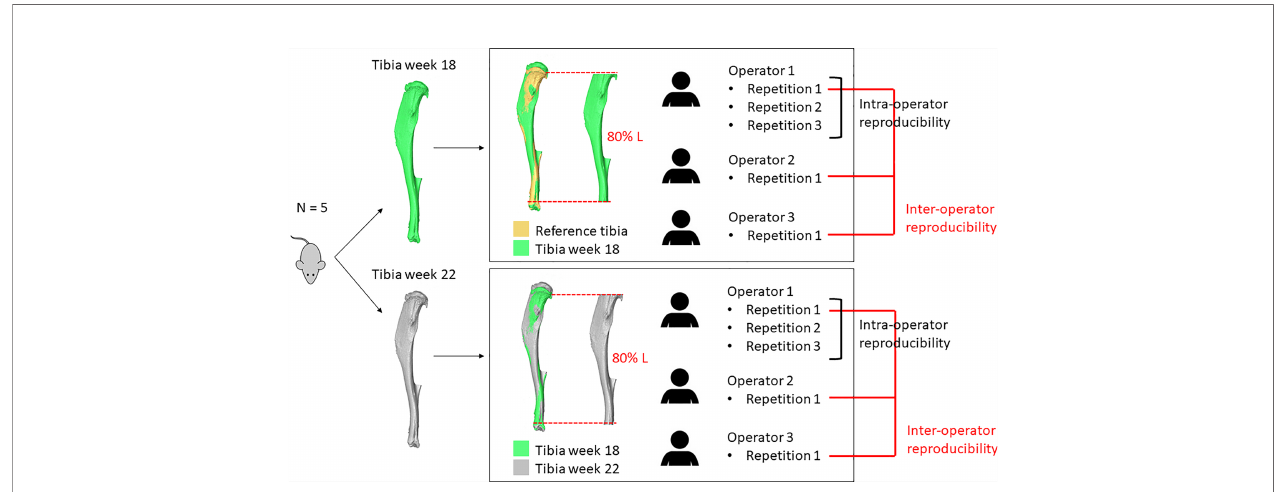
FIGURE 1 | Overview of the study. The right tibia of fi ve mice was microCT scanned longitudinally at week 18 and week 22 of age. Each image acquired at week 18 of age was aligned to a reference and a volume of interest (VOI, 80% Length) was selected. Each image acquired at week 22 of age was aligned to the corresponding baseline image and a VOI was selected. These operations were repeated three times by operator 1 and once by operators 2 and